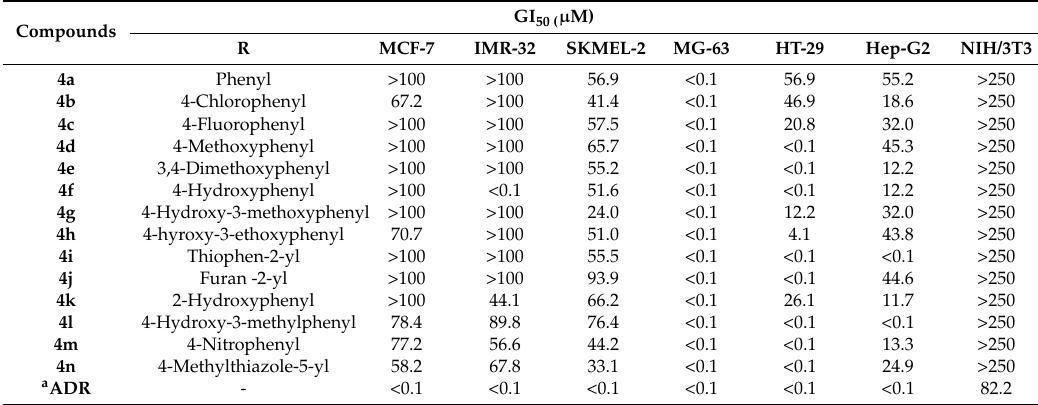
Table 2. In vitro Anticancer activity data of the novel synthesized compounds 4 ( a – n ).